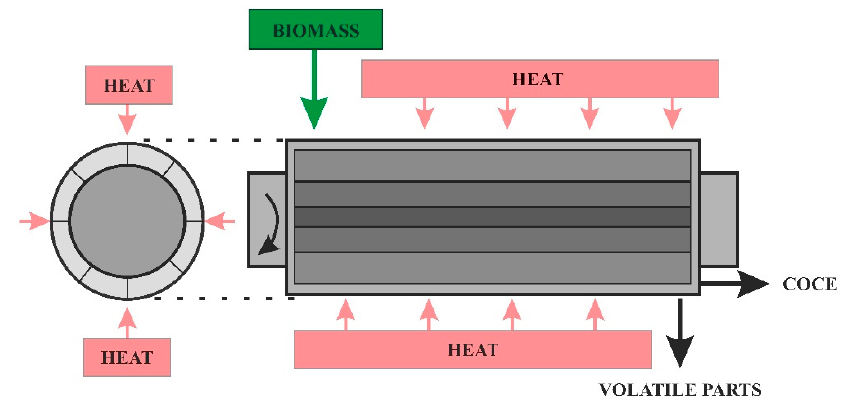
Figure 5. Ablative pyrolysis reactor